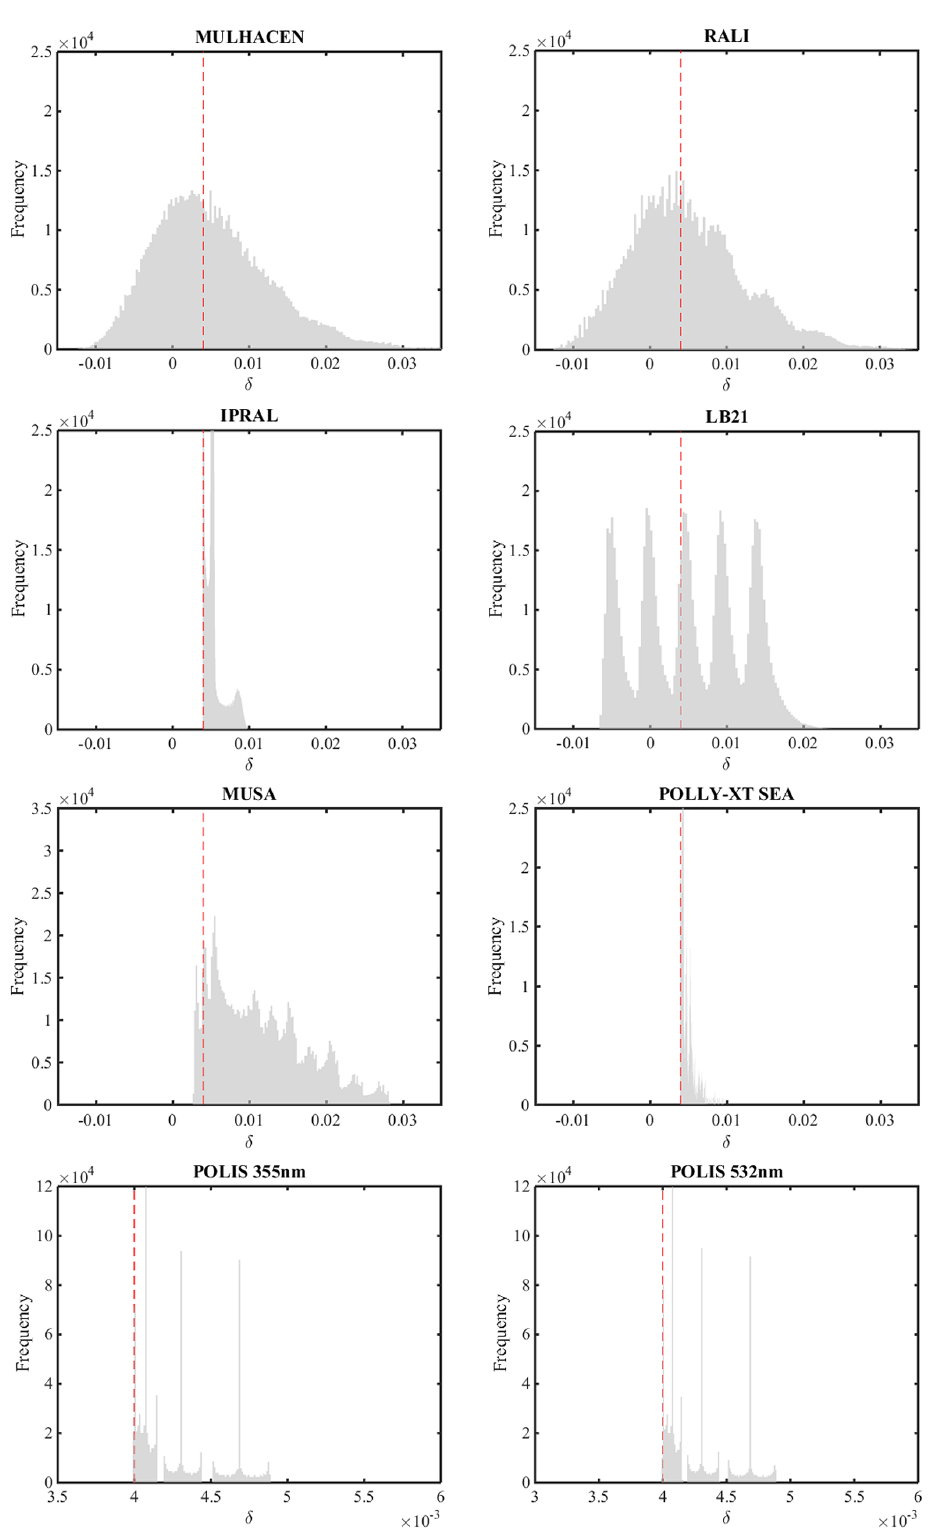
Figure 9. Histogram of the simulated δ values for several EARLINET lidars (Table 4). Dashed lines represent the δ r at 0004. Please note the expanded x axis for